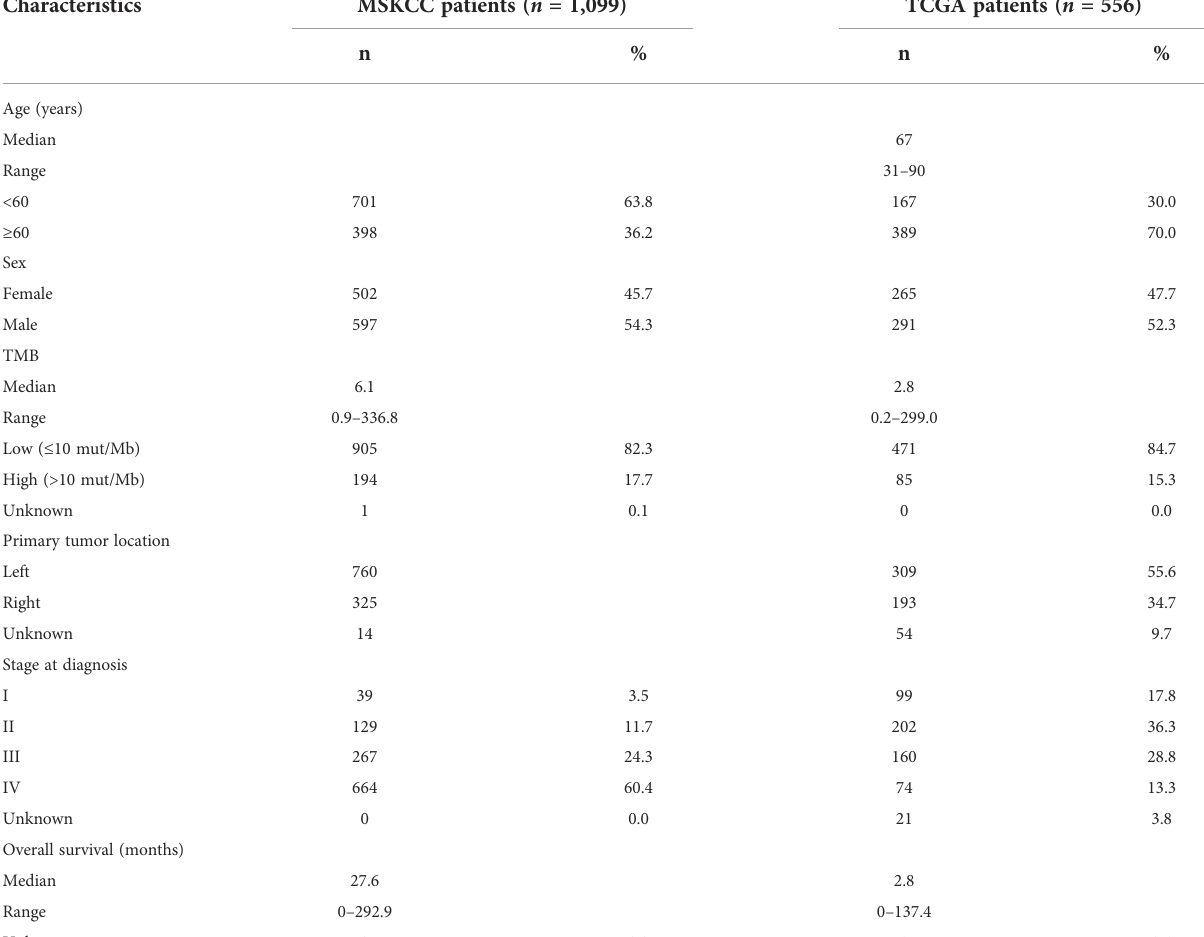
TABLE 1 Clinical characteristics of the study population.